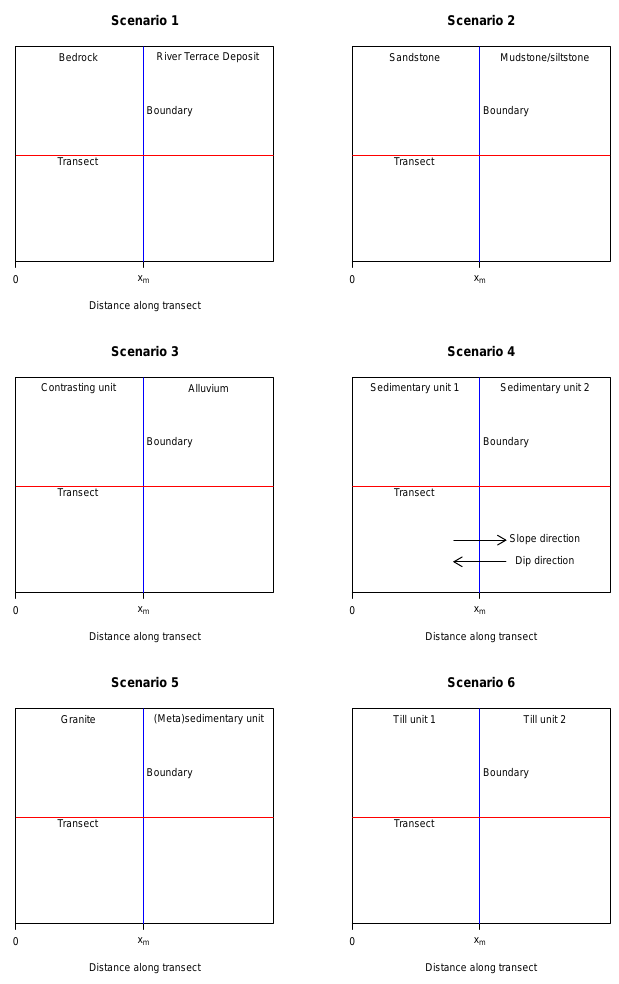
Figure 1. Diagrams indicating dispositions of units in each scenario with the mapped boundary shown as a blue vertical line and the notional transect as a red line, perpendicular to the boundary and with an origin on the